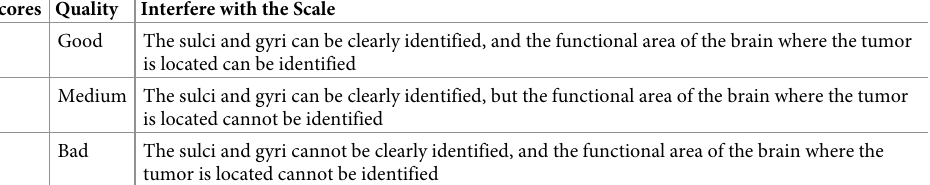
Table 1. Evaluation criteria